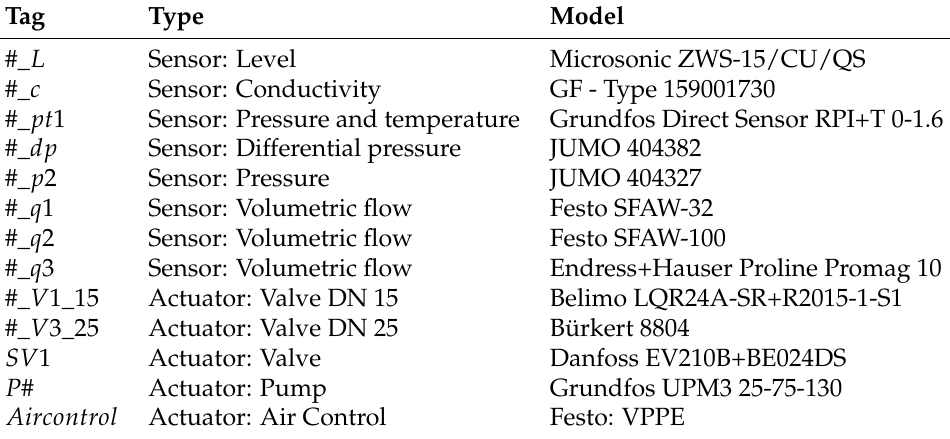
Table A1. List of sensors and actuators installed on the laboratory